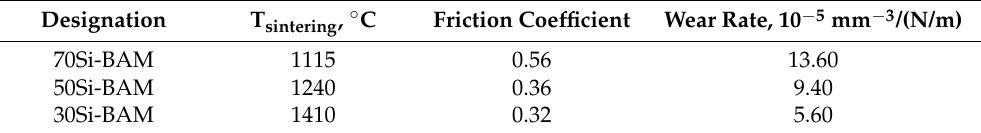
Table 4. Friction coefficient and wear rate of the sintered specimens.